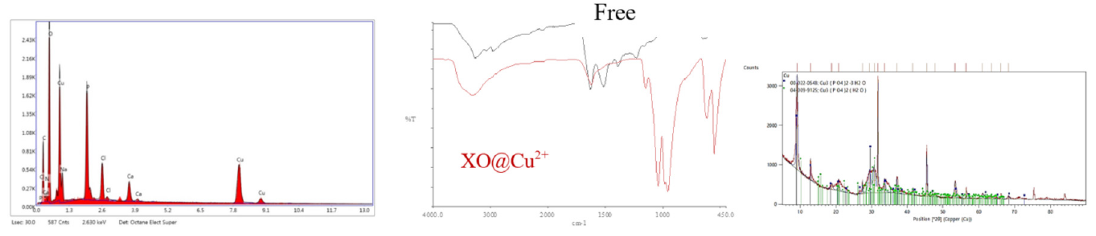
Figure 2. EDX, FTIR and XRD analysis of xo-Cu 2+